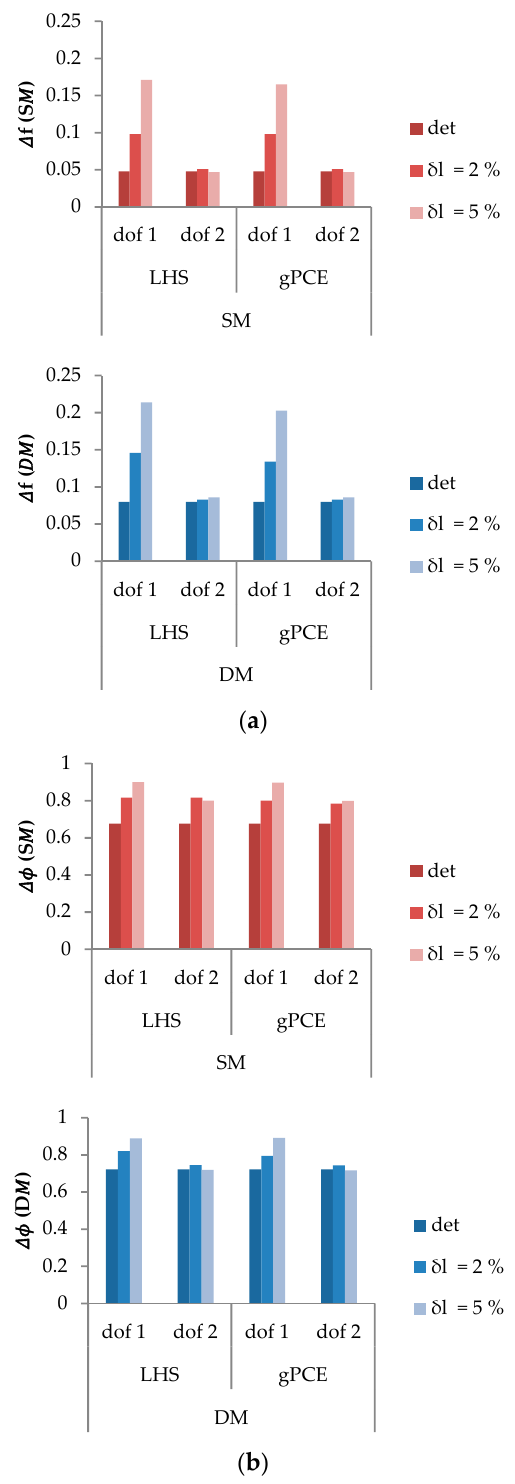
Figure 8. Evolution of ( a ) the frequency ranges and ( b ) the amplitude ranges of the multistability domain with respect to deterministic ones according to the SM and DM.